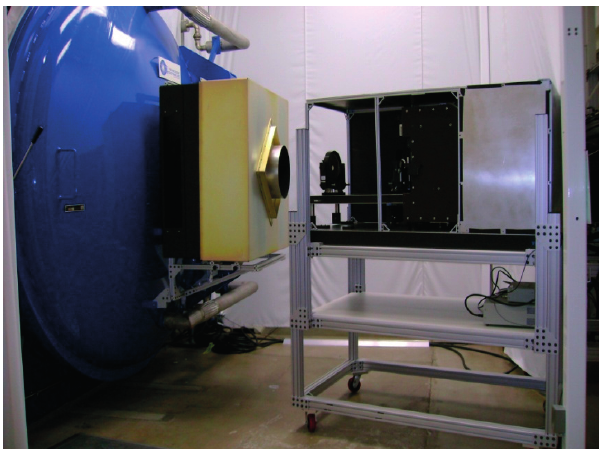
Figure 18. The spectral measurement assembly in front of the sphere. The gold box attached to the chamber is a light